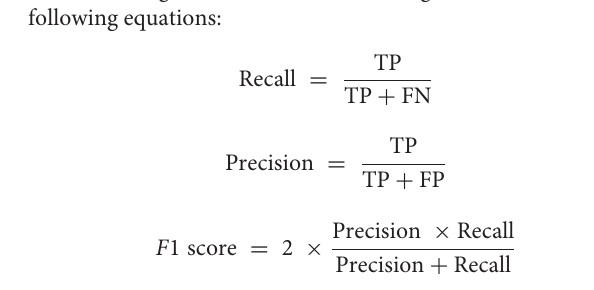
(FP), true negatives (TN), and false negatives (FN) using